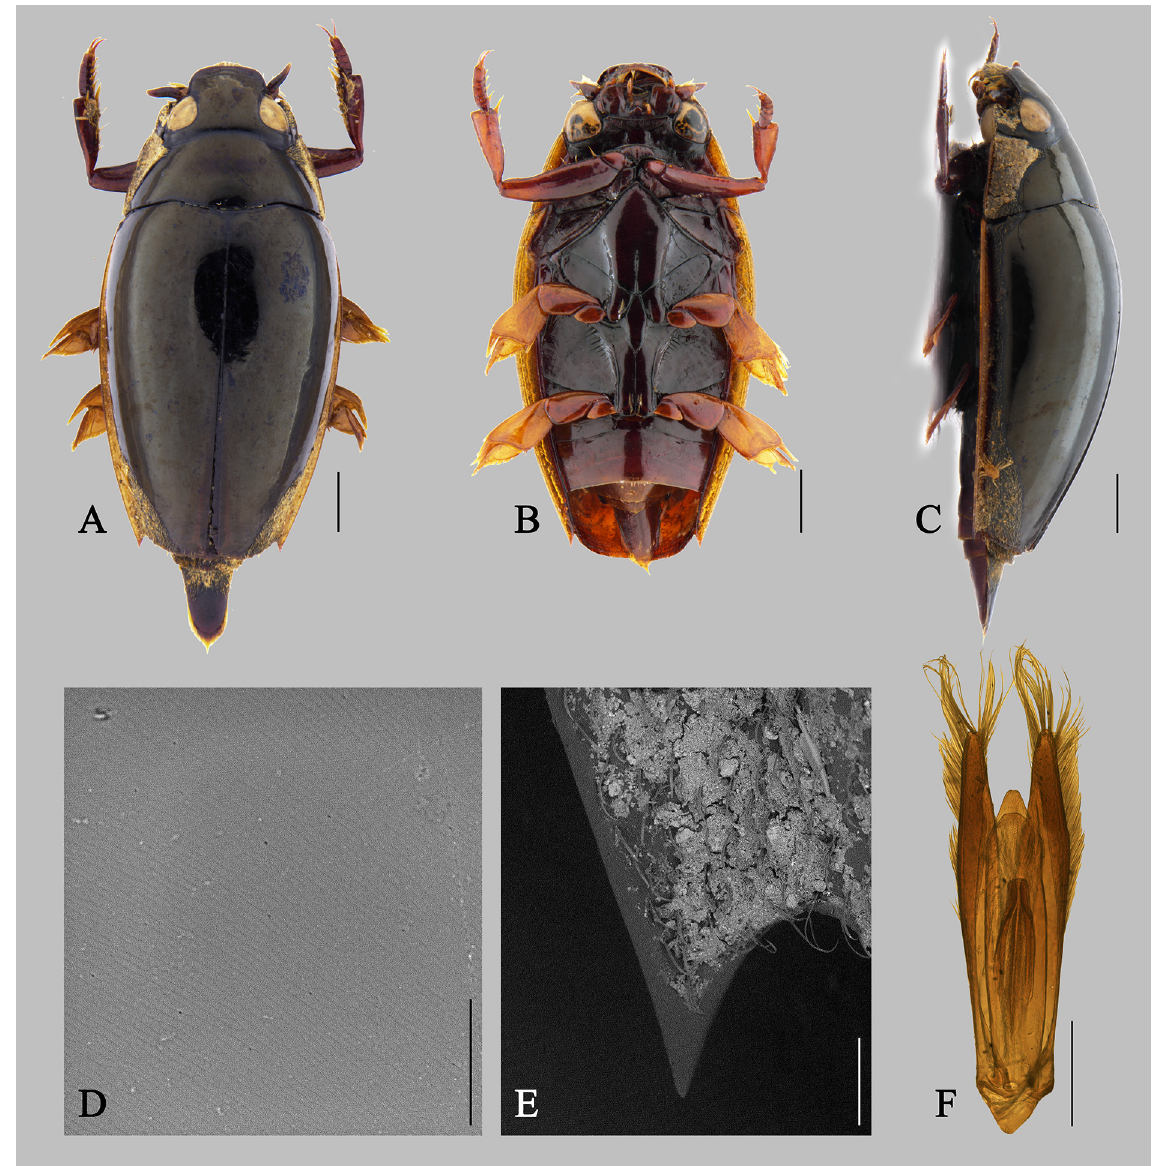
Fig. 11. Patrus annandalei (Ochs, 1925) (SYSU). A . ♀, habitus, dorsal view. B . ♀, habitus, ventral view. C . ♀, habitus, lateral view. D . ♀, surface sculpture on elytra. E . ♀, epipleural angle. F . ♂, male genitalia. Scale bars: A–C = 1 mm; D =30 μm; E = 100 μm; F = 0.5